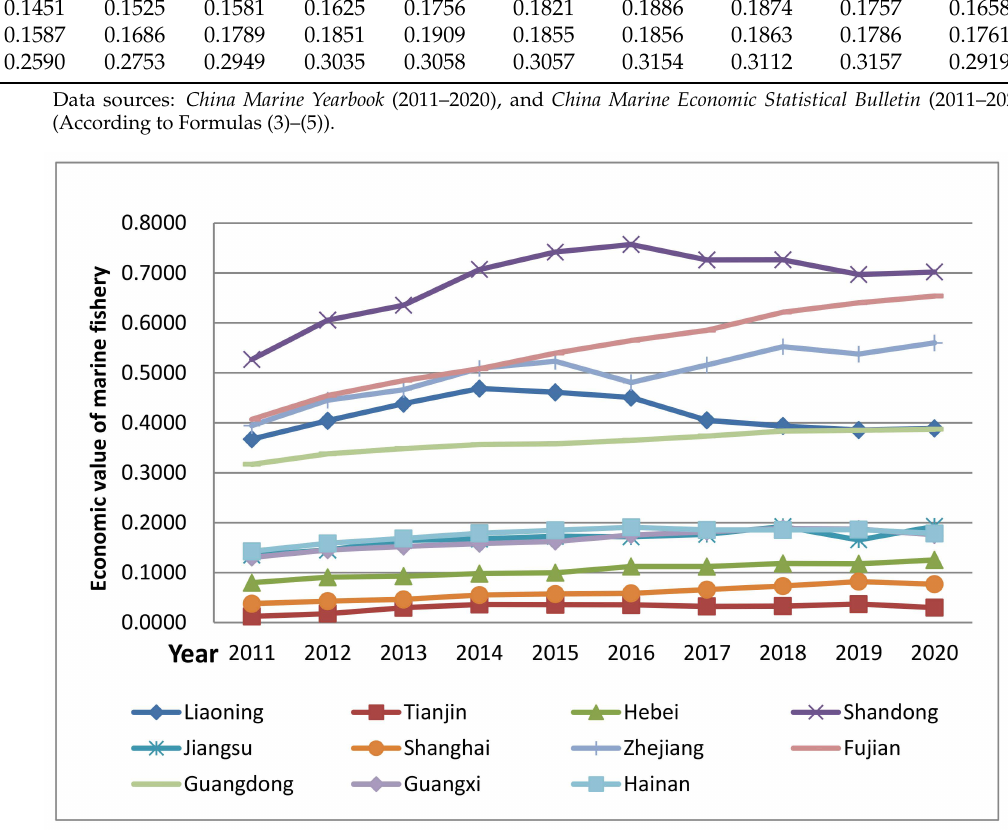
Figure 1. Changes in the economy quality of marine fisheries